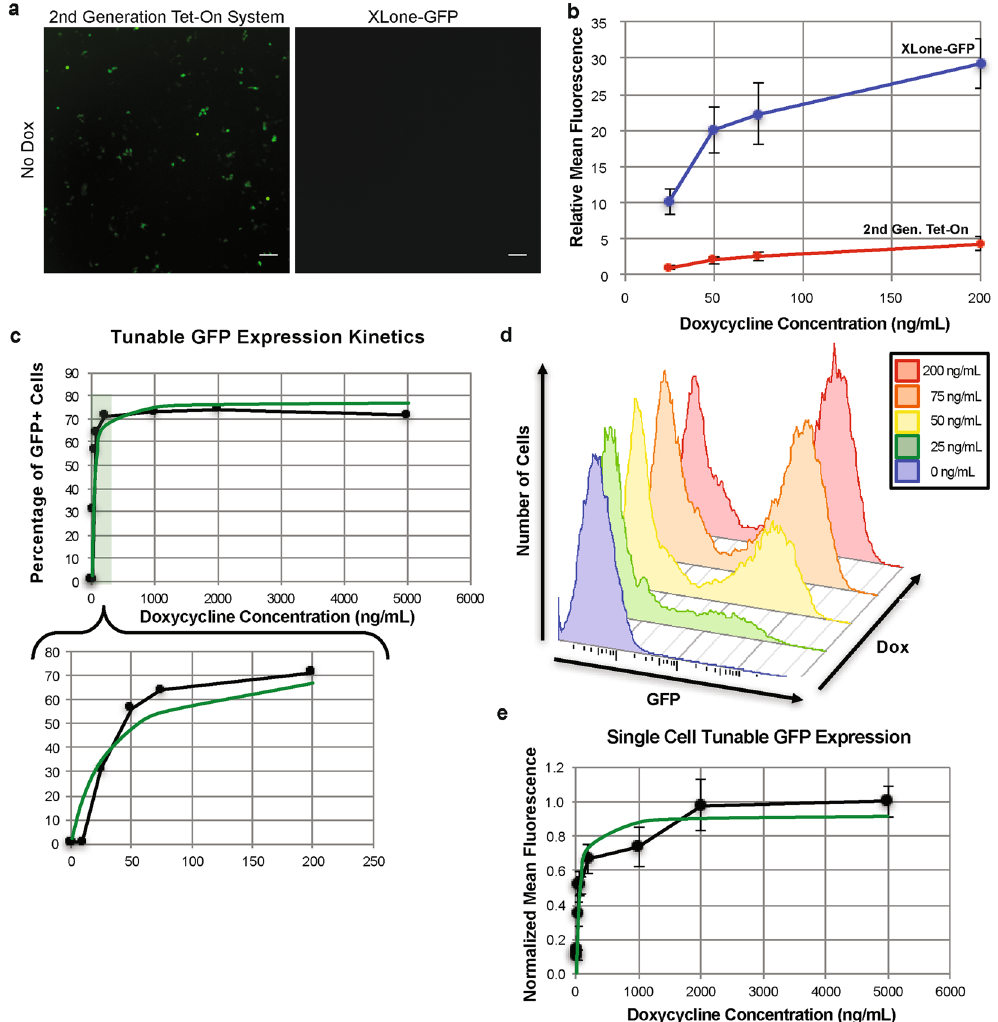
Figure 3. Characterization of XLone tunable expression pattern. ( a ) Fluorescence microscopy images showing background (without Dox exposure) GFP expression comparison between a 2 nd generation Tet-On system and the XLone-GFP construct in 293TN cells. Scale bars are 100 µ m. ( b ) Plot showing the mean fluorescence of 293TN cells exposed to lower Dox concentrations. The blue and red lines represent the XLone-GFP construct and 2 nd generation Tet-On system respectively. Error bars show standard error of the mean (n = 18). Student t-test was used for statistical analysis for each Dox concentration comparing the 2 nd Tet-On system and XLone system. ( c ) Tunable expression kinetics of the inducible plasmid system fit by the Michaelis-Menton equation with K m of 30.8 ng/mL and V max of 77.32%. ( d ) Flow cytometric analysis of tunable GFP expression. The plot shows changes in the number of cells expressing GFP with increasing doxycycline concentration over the 10–200 ng/mL dosing range. ( e ) Plot illustrating the normalized average corrected total fluorescence of single cells with exposure to varied doxycycline concentrations. The non-linear curve fit is based on Michaelis-Menten kinetics with a fitted K m of 51.2 ng/mL and V max of 0.92. The error bars shown represent the standard error of the